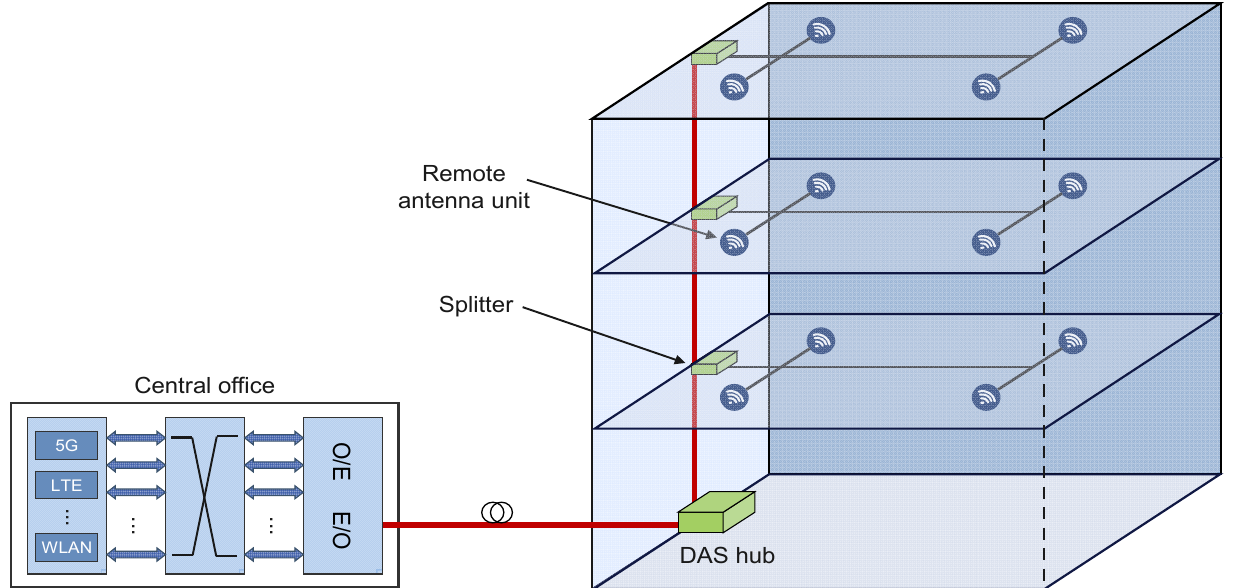
Figure 8. An example of indoor DAS implementation.